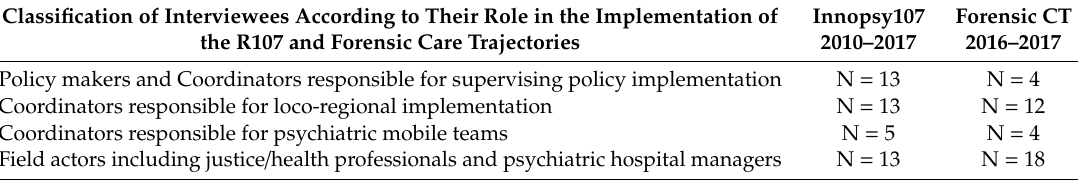
Table 1. Classification of interviewees according to their role in the implementation of the Innopsy107 and forensic care trajectories (CT).